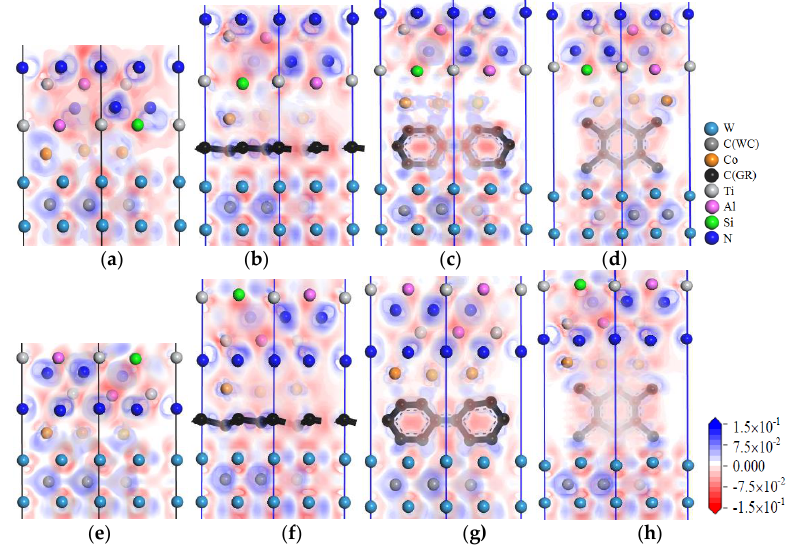
Figure 9. Charge-density difference image of the interface models with intrinsic graphene doping in the matrix: ( a ) TiAlSiN Si /WC-Co; ( b ) TiAlSiN Si /WC/msGR/Co; ( c ) TiAlSiN Si /WC/acGR/Co; ( d ) TiAlSiN Si /WC/zzGR/Co;